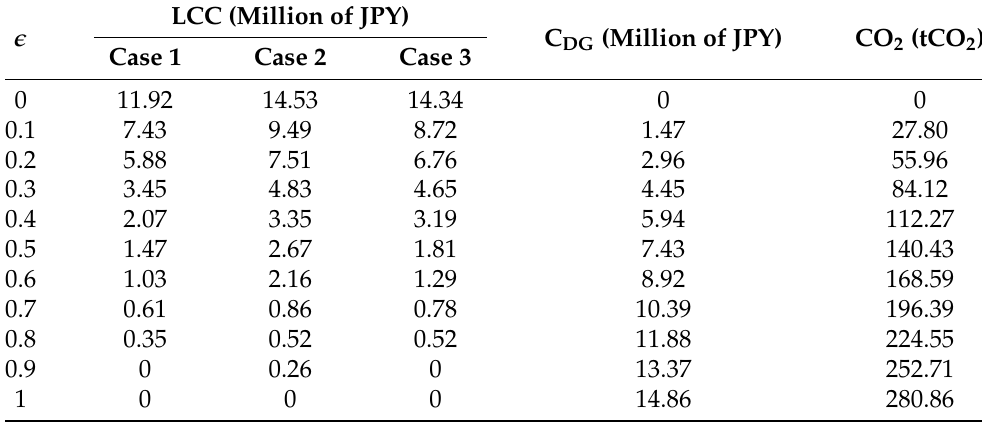
Table 2. Cost of each